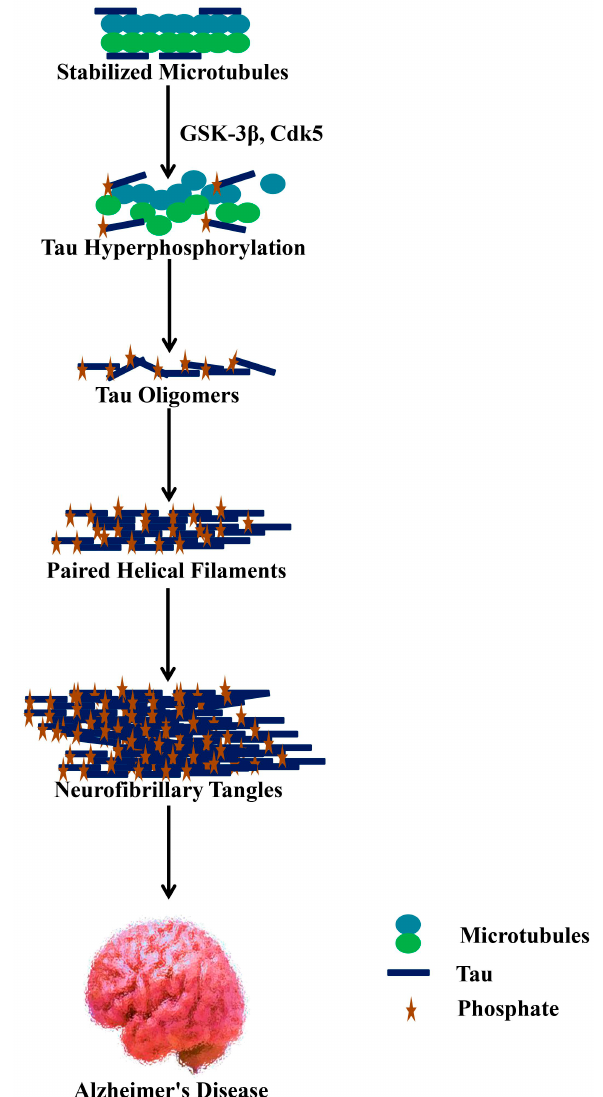
Figure 2. Hyperphosphorylated tau dissociates from microtubules and depolymerizes as well as aggregates as neurofibrillary tangles. GSK-3 β , glycogen synthase kinase 3 β ; Cdk5, cyclin-dependent kinase 5.